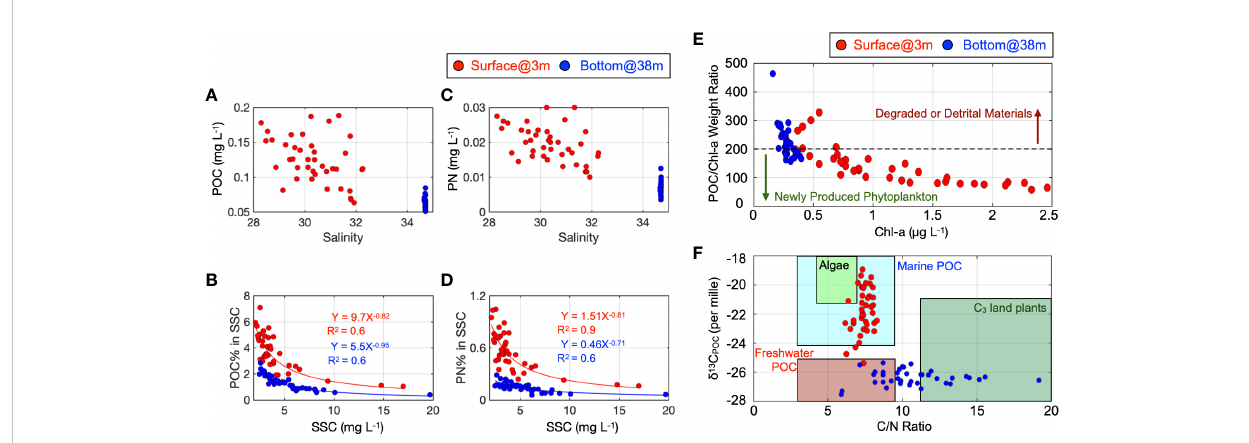
FIGURE 6 Measured OM parameters from water samples taken at the 3 (red) and 38 m (blue) depths, respectively. (A) The concentration of POC vs. salinity, (B) the POC% is plotted against the SSC with power regression lines, R 2 , and the fi tting equations. (C) The concentration of PN vs. salinity, (D) the PN % is plotted against the SSC with the power regression lines, R 2 , and the fi tting equations. (E) The POC to Chl-a ratio vs. measured Chl-a at the surface (red dots) and bottom (blue dots). The black dashed line indicates the demarcation value at 200. (F) The d 13 C POC vs. C/N diagram. Boxes indicate the different domains of OM in the C/N vs. d 13 C POC diagram (data compiled from Bordovskiy, 1965; Haines, 1976; Sherr, 1982; Schidlowski et al., 1983; Meyers, 1994; Peterson et al., 1994; Middelburg and Nieuwenhuize, 1998; Chivas et al., 2001; Raymond and Bauer, 2001; Cloern et al., 2002; Lamb et al., 2006; and references